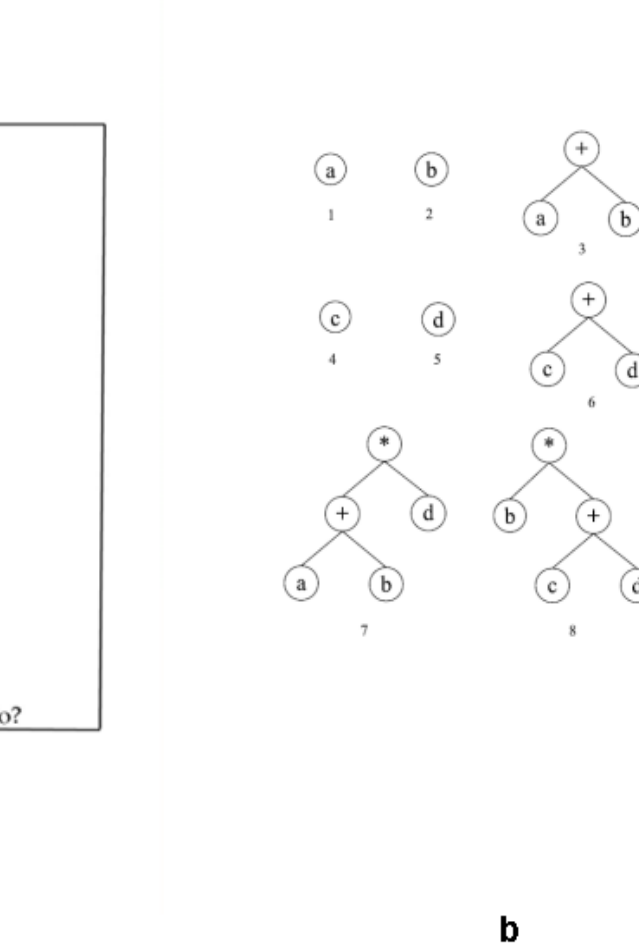
Table 1. Coefficient of correlation (R) for explanatory variables.